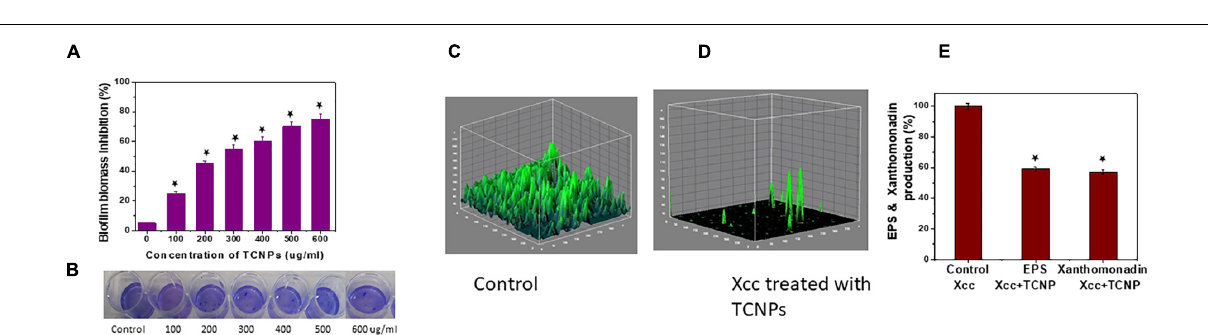
Frontiers in Microbiology |